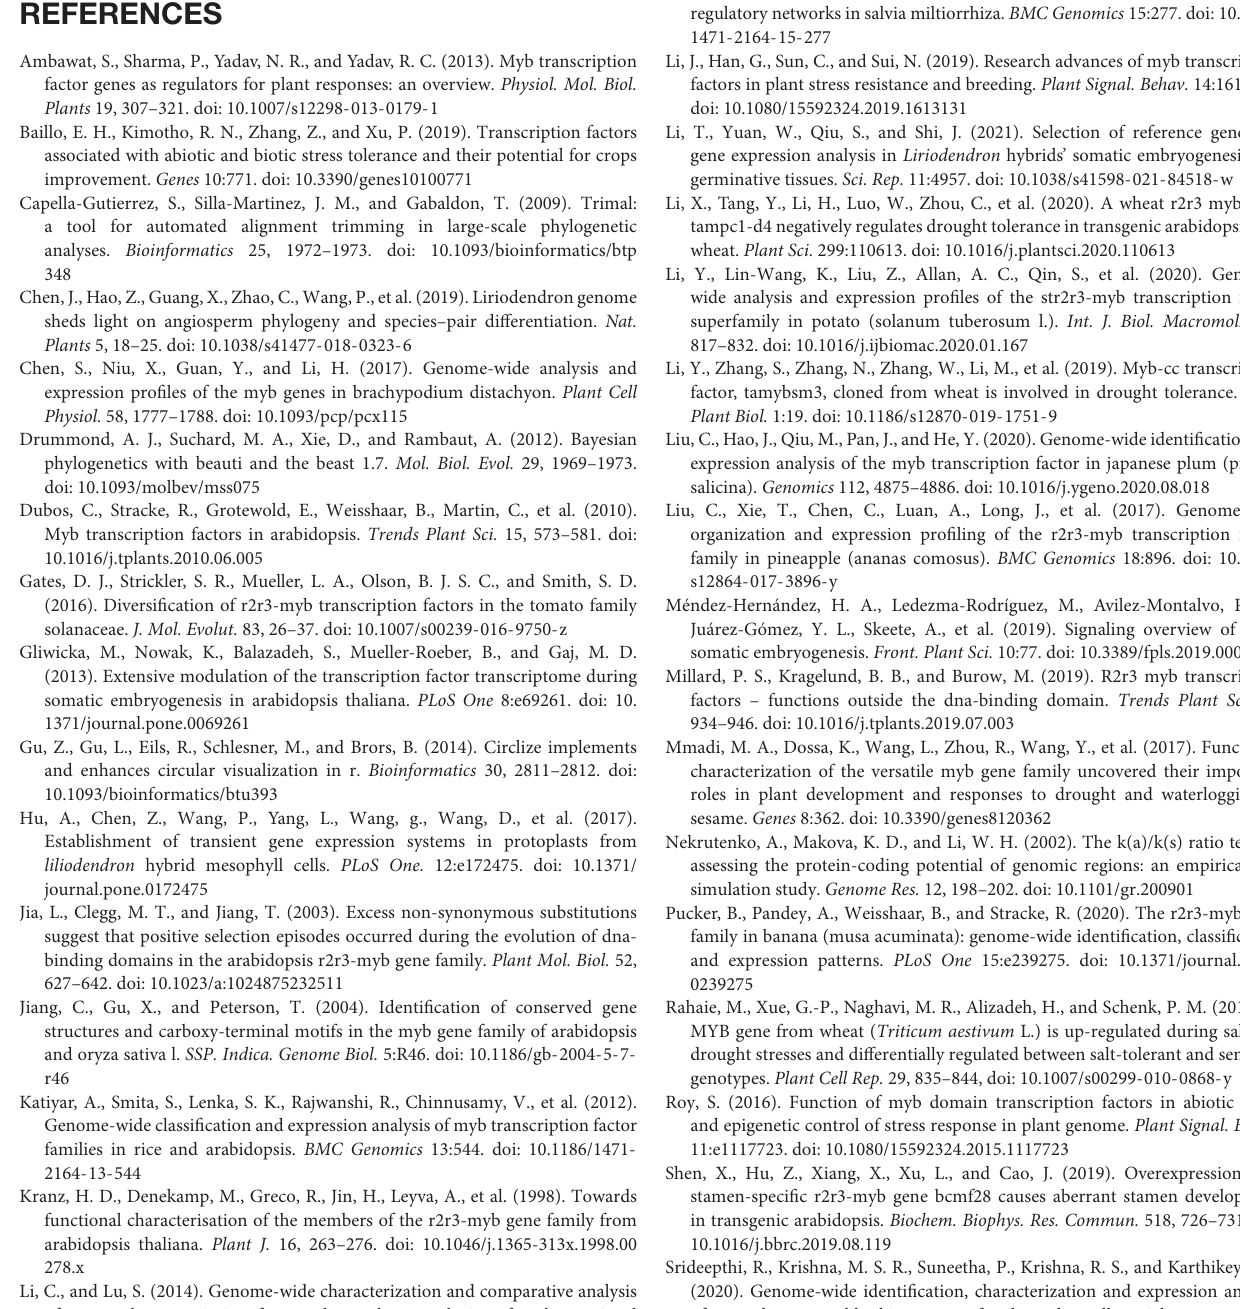
Supplementary Table 12 | Number and length of the exon-intron structure of LchiR2R3-MYBs . Supplementary Table 13 | Cis elements of LchiR2R3-MYBs . Supplementary Table 14 | TPM value of LchiMYBs under cold, heat, and drought